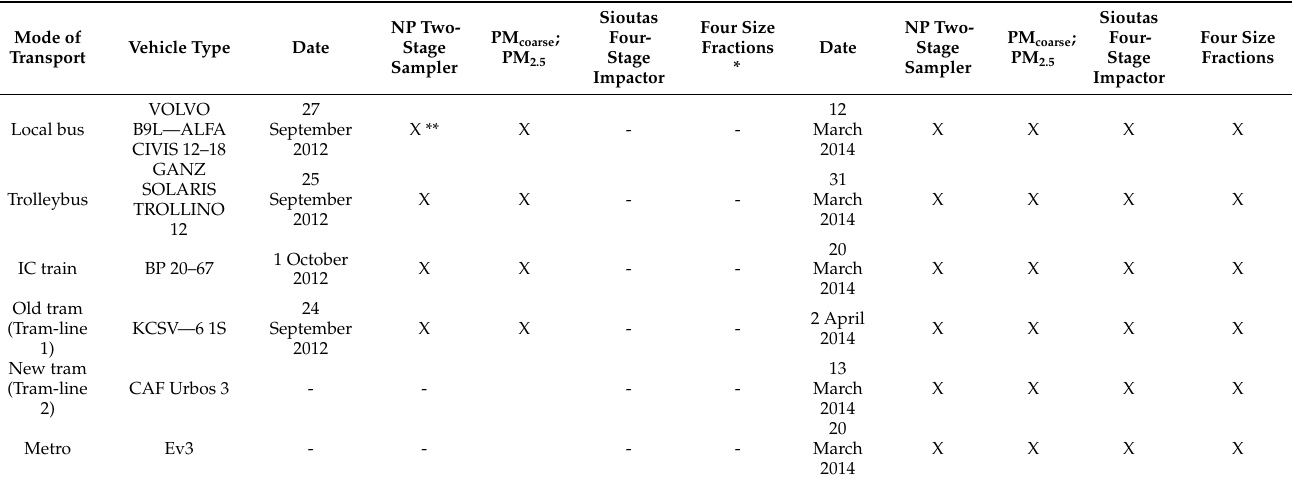
Figure 1. Map of the investigated transport lines: the location of the ATOMKI UB site and the Hungarian Air Quality Monitoring Network (HAQN) sites in Debrecen; the railway line between Debrecen and Budapest; the M3 metro line in Budapest. Table 1. Vehicle types, sampling dates, the lengths of the lines (in km), the applied sampling devices and the measured size